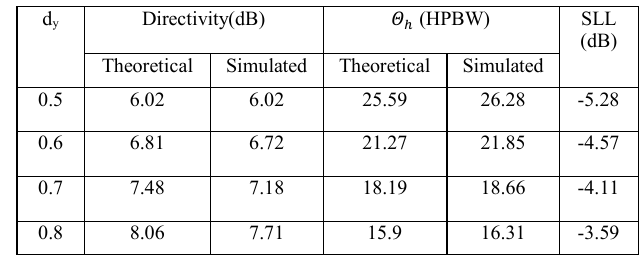
Table 9: Linear antenna array (N = 4 , βy = 0°)